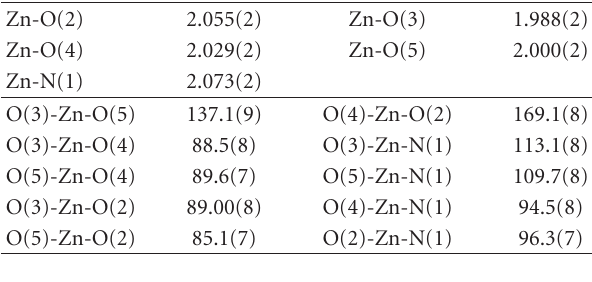
Table 2: Selected interatomic distances ( ˚A) and angles ( ◦ ) for complex 1 · H 2 O.